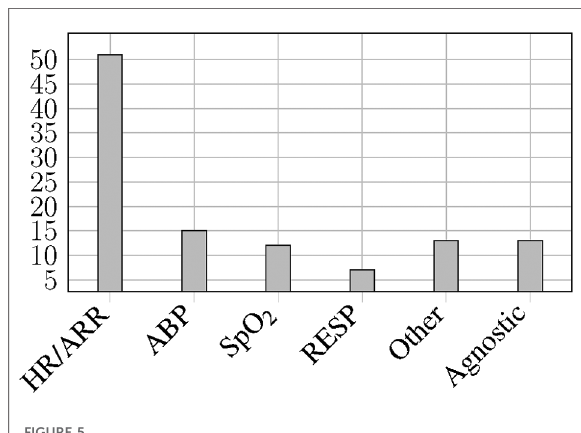
FIGURE 5 Investigated alarm types or